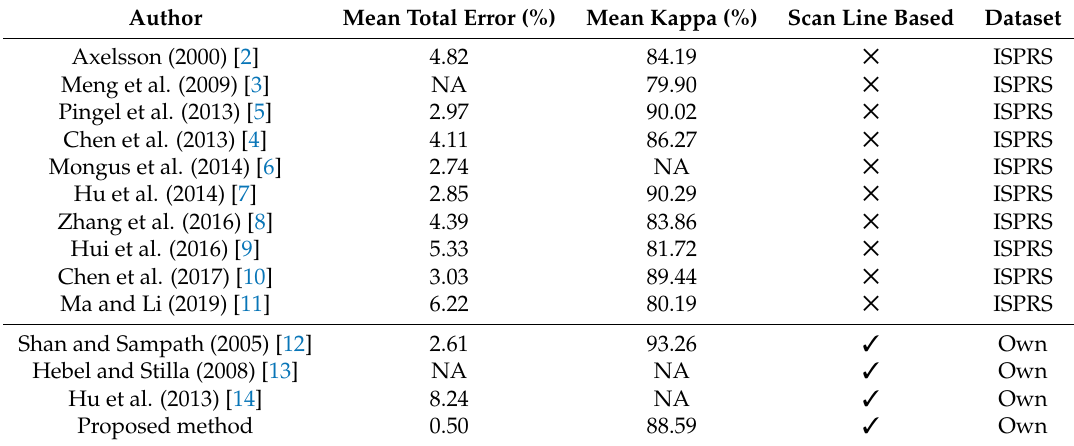
Table 8. Mean total error and kappa coefficients compared to other